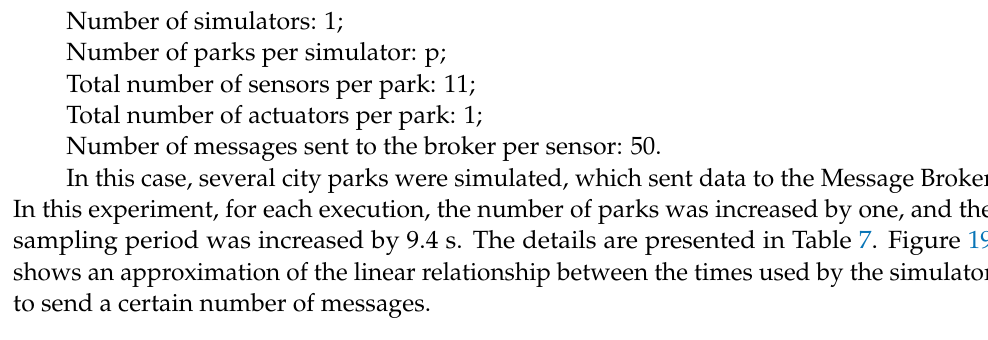
Table 7. Experiment 3.